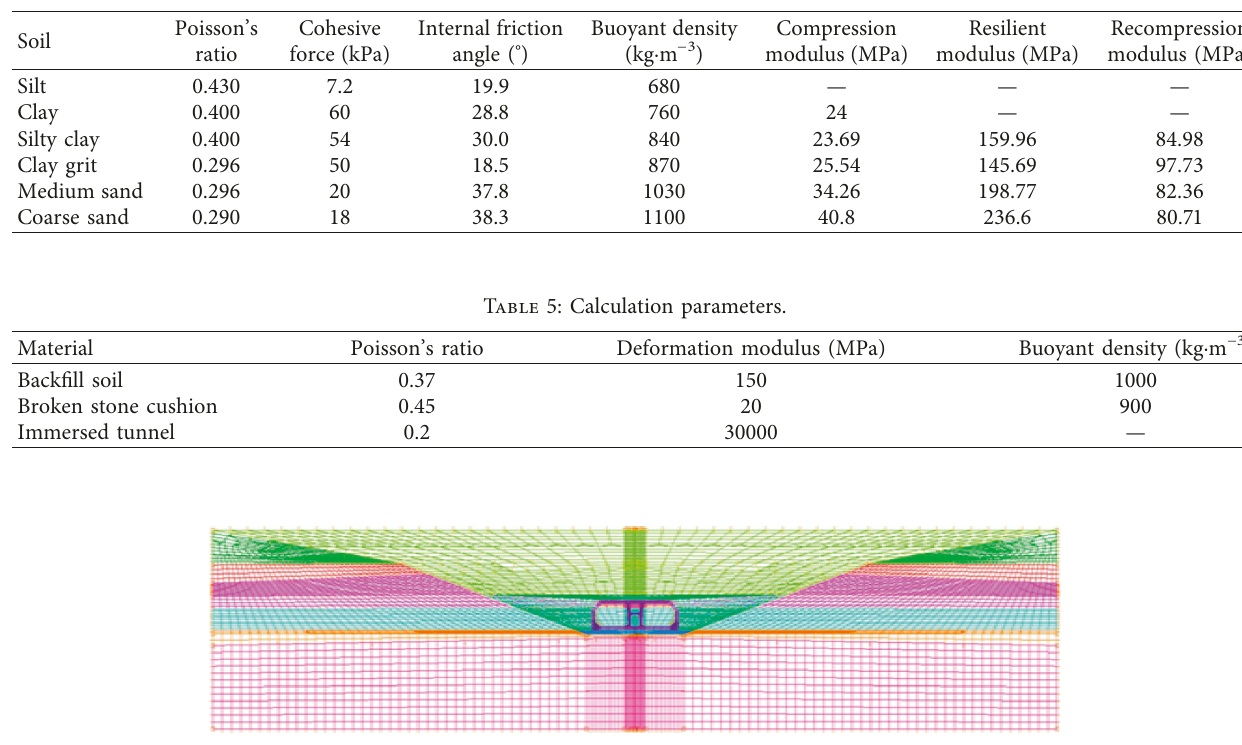
Table 4: Soil layer parameters.